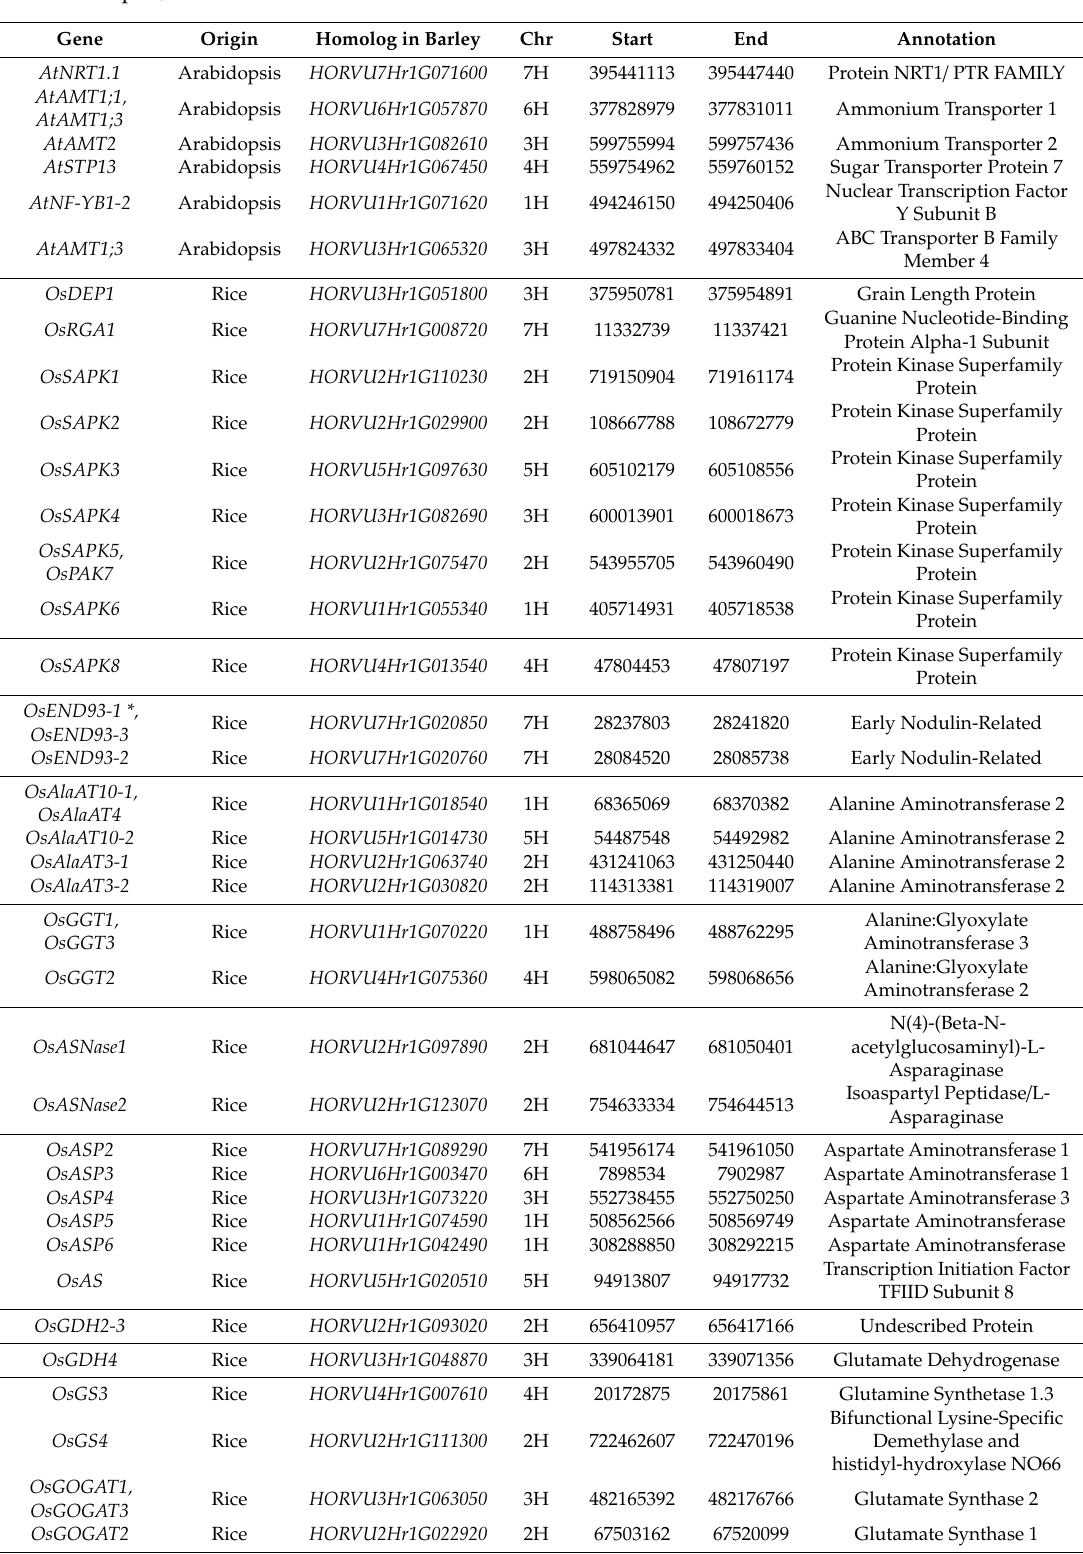
Table 3. Chromosome position of the homologous candidate genes controlling NUE in barley from Arabidopsis, rice and